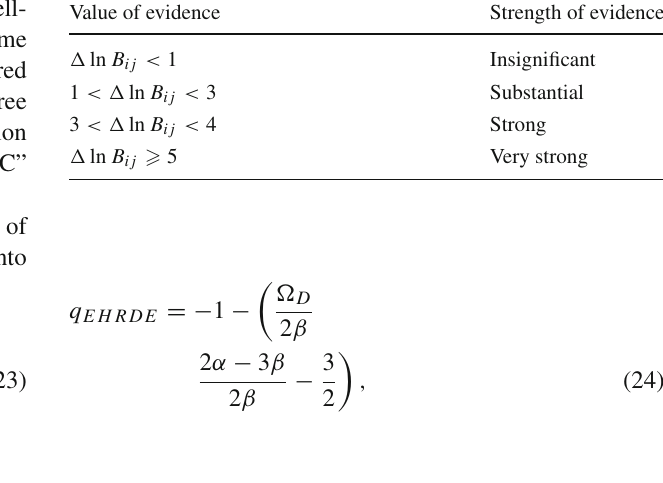
Table 6 The definition of strength of evidence for model M i according to Jeffrey’s scale [121] Value of